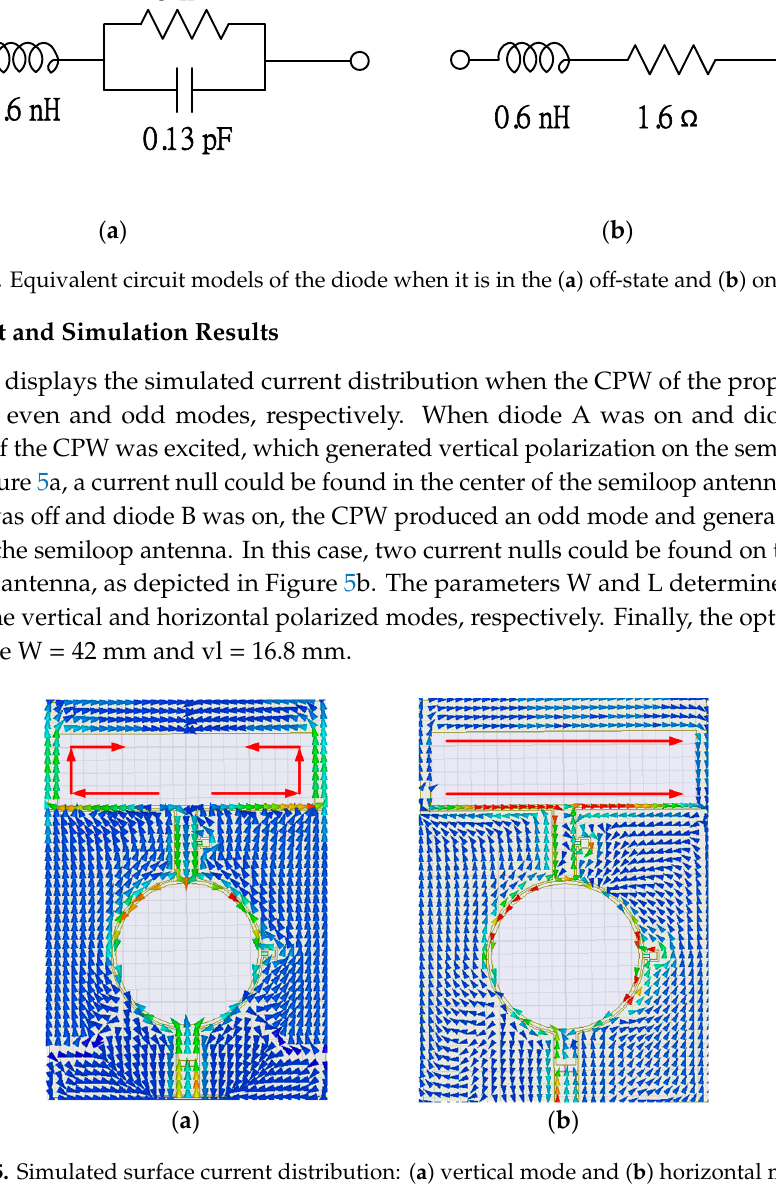
Figure 6. The fabricated prototype.